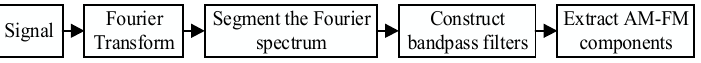
Figure 2. EWT workflow.